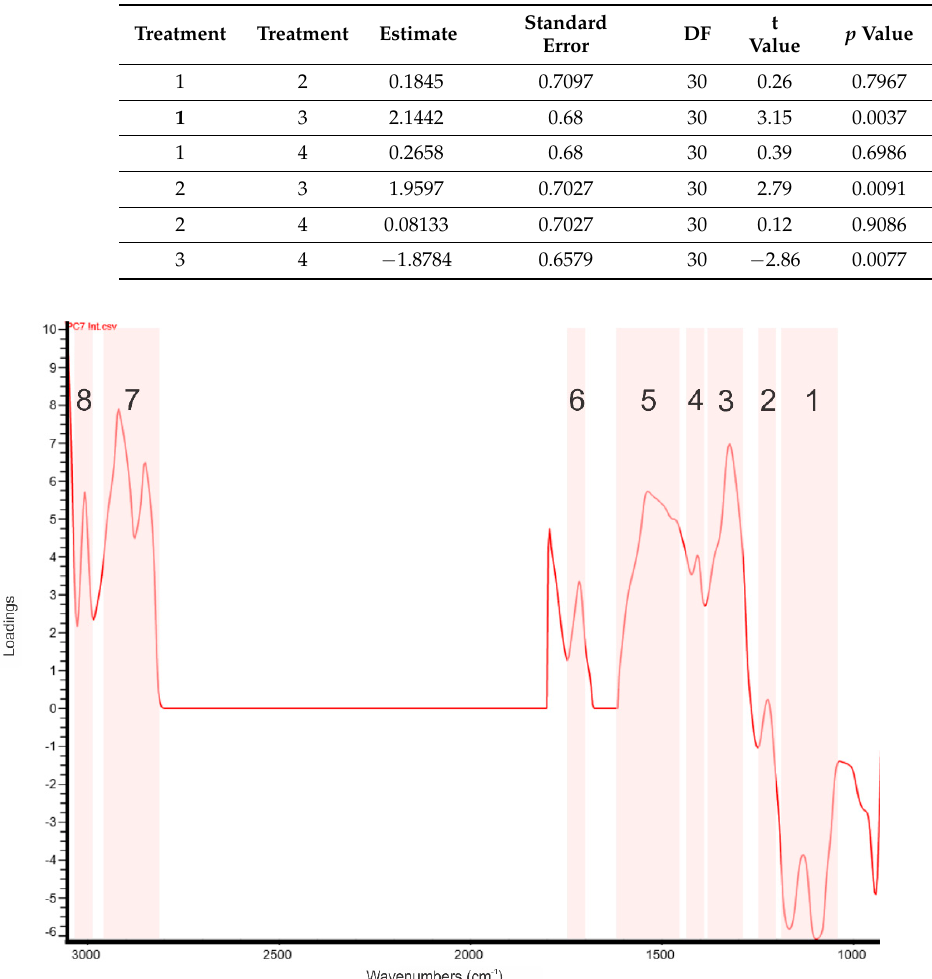
Figure 2. The spectral integral of the PC7 loading spectrum extracted from the long-term VN-FD spectral average dataset for the tie-rail trial. Shaded regions can be assigned to (1) lactose 1200–1000 cm − 1 , (2) acetone ~1237 cm − 1 , (3) citrate, BHB and acetone 1390–1250 cm − 1 , (4) BHB ~1404 cm − 1 , (5) fatty acids and carboxylate ion in citrate, BHB, free fatty acids and acetate 1618–1424 cm − 1 , (6) carboxylic group of free fatty acids ~1716 cm − 1 , (7) CH stretching of fatty acids 3000–2800 cm − 1 , and (8) =C–H stretching of fatty acids ~3008 cm − 1 . which did not show any clear peaks. In the first region, a probable peak was detected